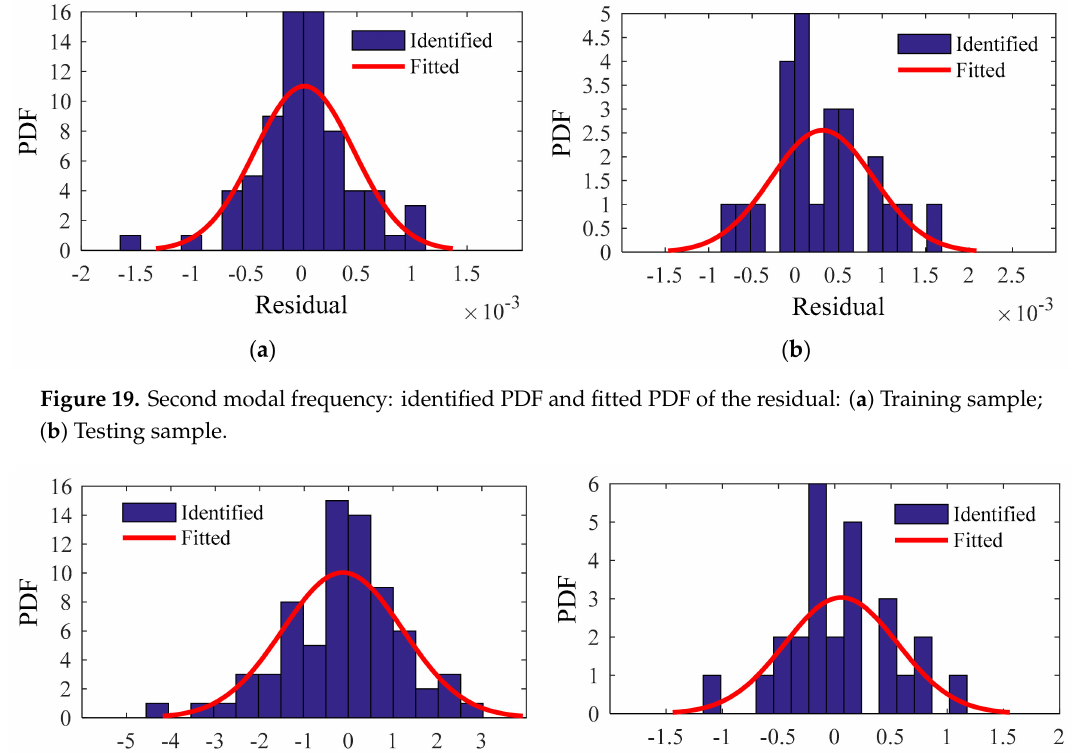
Figure 18. First modal frequency: identified PDF and fitted PDF of the residual: ( a ) Training sample; ( b ) Testing sample.